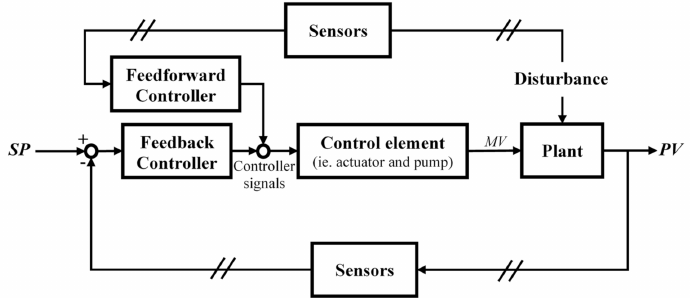
Figure 1. Structure of a typical control